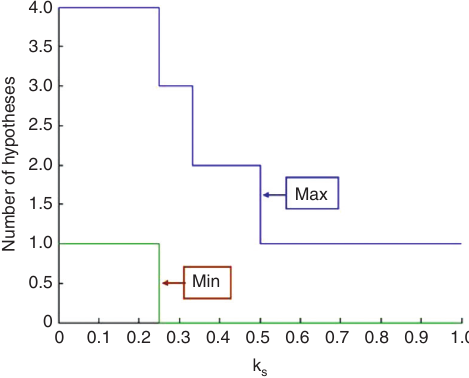
Figure 6. Number of Potential Hypotheses for the Decision